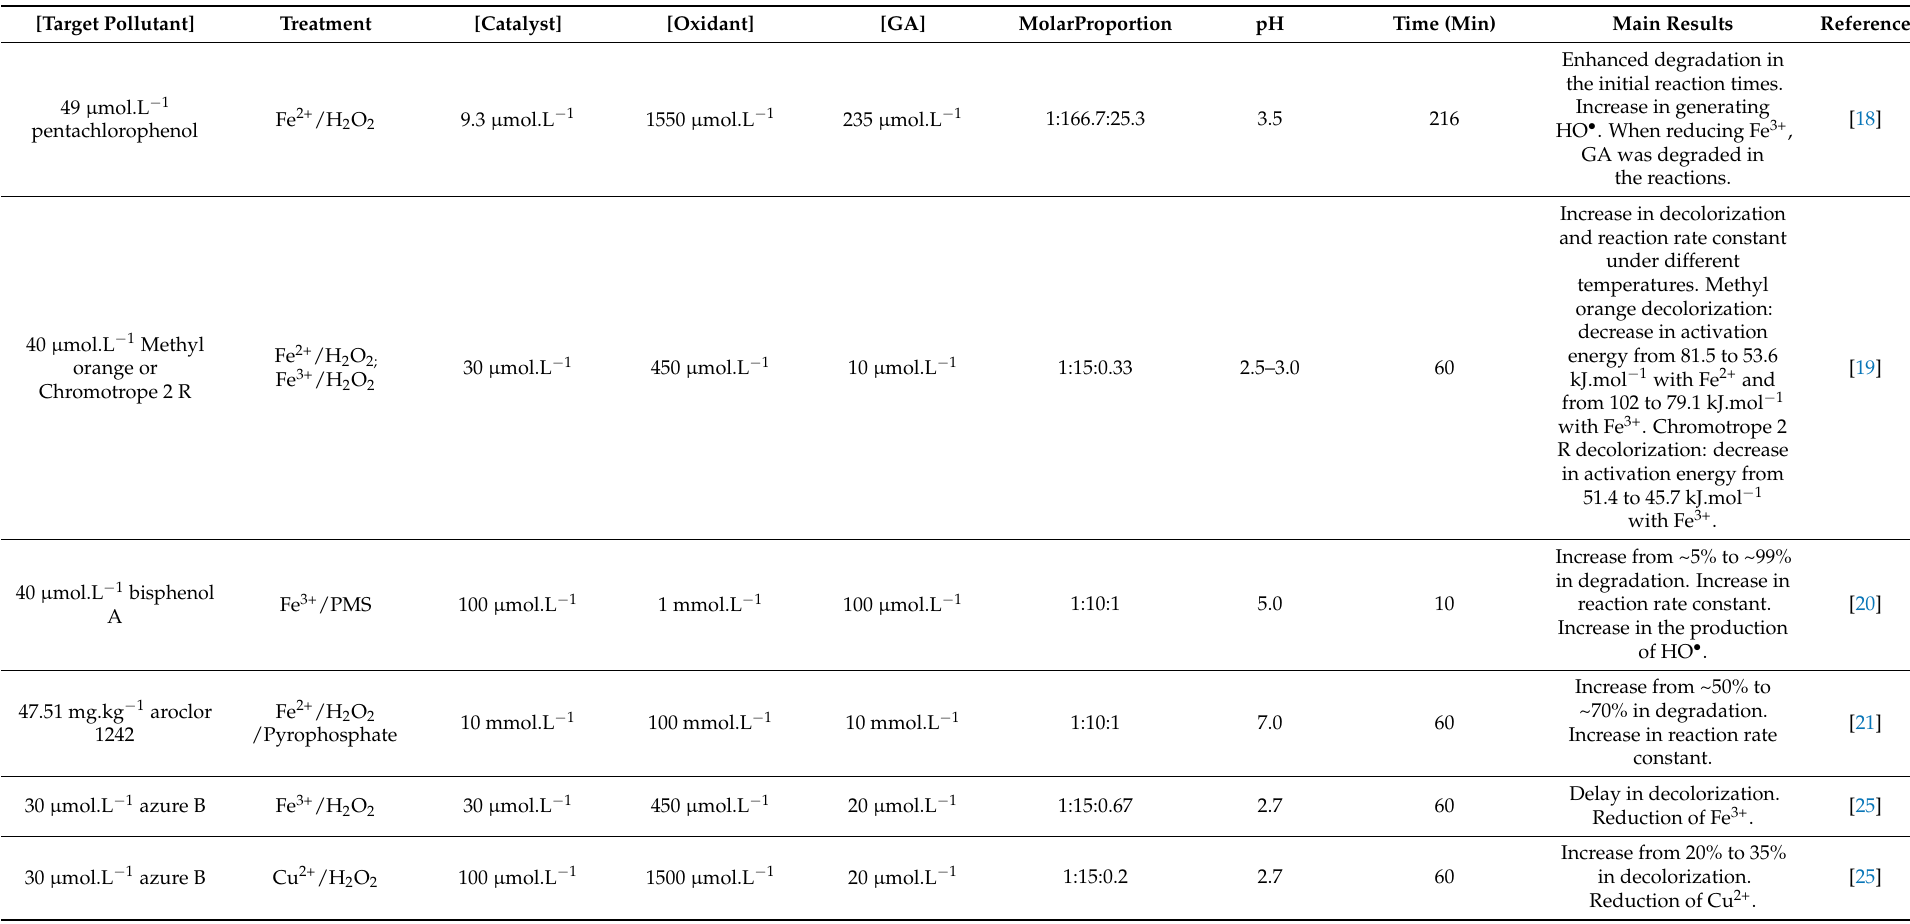
Table 2. Target organic pollutants degradation by Fenton processes in presence of gallic